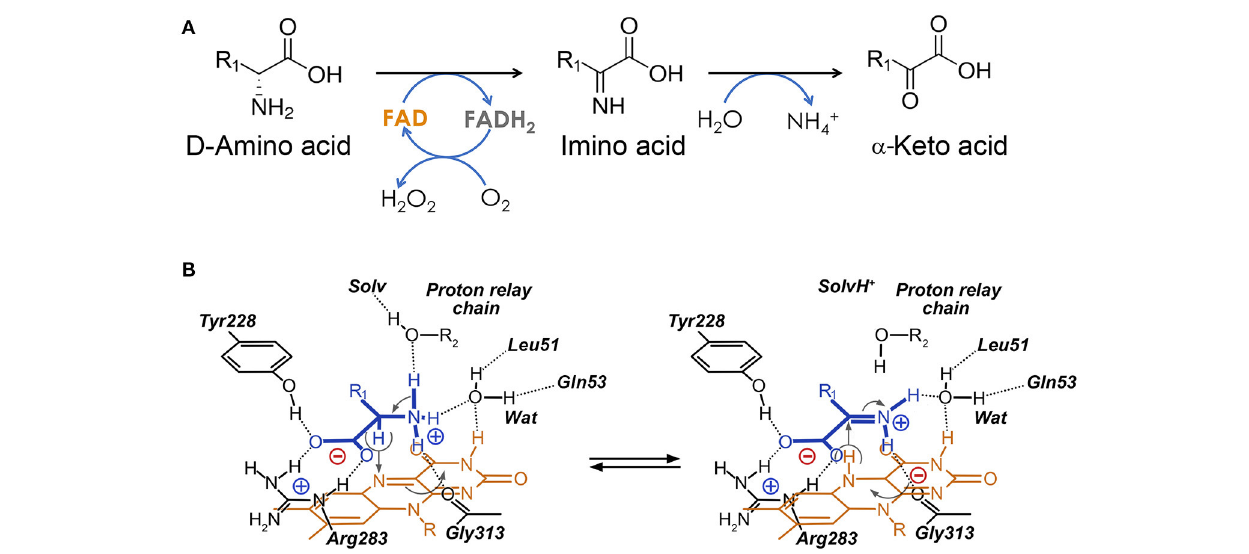
FIGURE 1 | Reaction catalyzed by human D-amino acid oxidase. (A) Scheme of the reaction. R 1 represents the side chain of the substrate. (B) Schematic representation of the hydride transfer mechanisms. The D-amino acid is bound in its zwitterionic form. Substrate is colored in blue. H-bonds are represented as dotted lines. Arrows, indicating relocation of electrons during the reaction, are represented in gray. Wat: putative active-site water molecule. R 1 : side chain of the substrate. The first H acceptor of the proposed proton relay chain (at pH < 8) has not yet been identified: it could be an active-site water molecule (R 2 = H) or the hydroxyl of a protein residues (R 2 = protein).